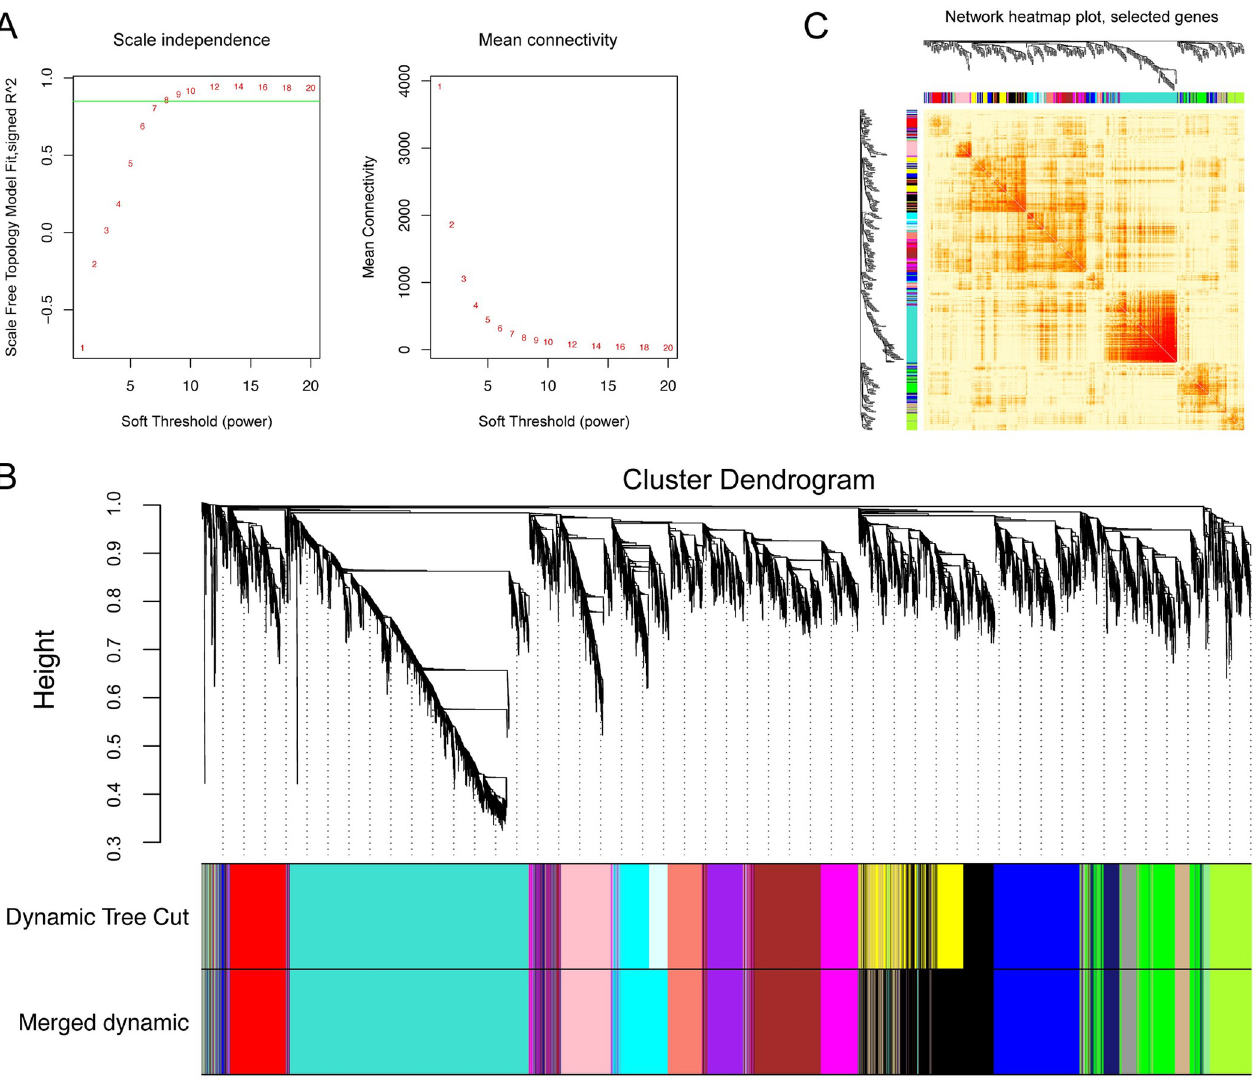
Fig 4. WGCNA analysis revealed the gene co-expression network of hLNs, pBLs and spleen at 3, 42 and 70 dpi, respectively. (A) Analysis of the scale-free network analyzed the weight of soft thresholds (left) and the average connectivity of various soft thresholds (right). (B) Cluster dendrogram of hLNs, pBLs and spleen genes. (C) Network heatmap of 400 randomly selected genes in co-expression module (the red gradient indicates the higher overlap area of functional